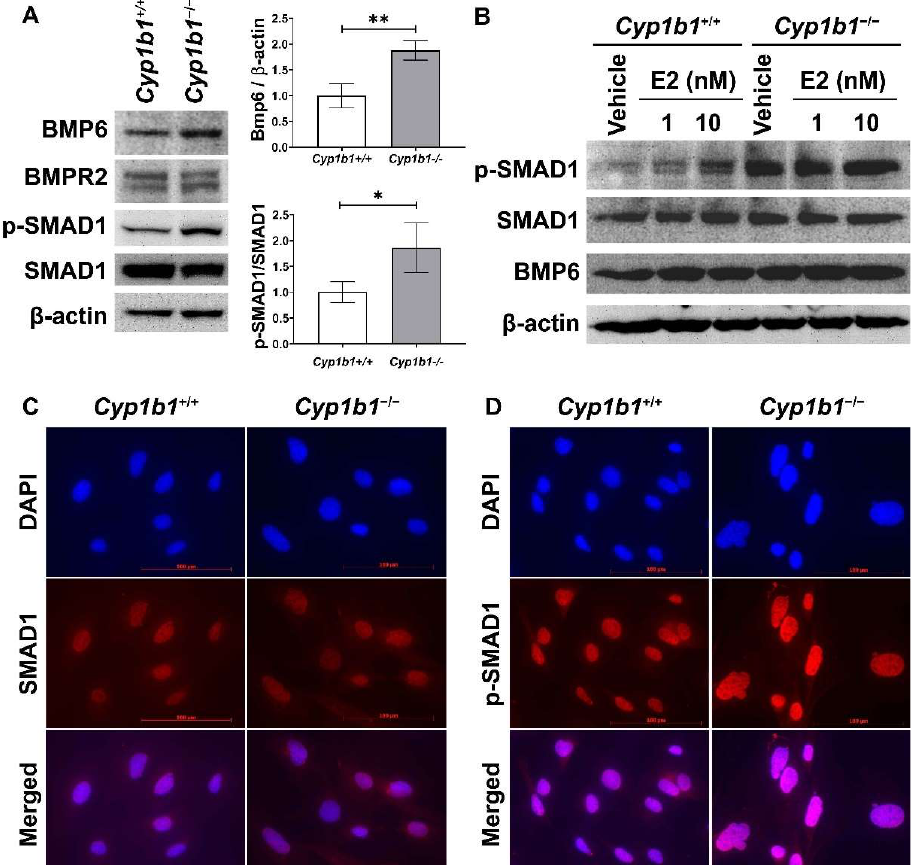
Figure 2. Up-regulation of BMP6 signaling pathway in Cyp1b1 −/− retinal ECs. ( A ) The cell lysates were prepared and used for the analysis of protein levels involved in BMP6 signaling pathway by Western blotting, as detailed in Methods. The levels of BMP6, BMP receptor 2 (BMPR2), p-SMAD1, and SMAD1 proteins were determined using specific antibodies. β-actin levels were determined as a loading control for cell lysates. Band densities were measured from 3 (BMP6/β-actin) and 4 (pSMAD1/SMAD1) blots and analyzed using ImageJ (right panel, * p < 0.05, ** p < 0.01). ( B ) Cyp1b1 +/+ and Cyp1b1 −/− retinal ECs were incubated with 1 nM or 10 nM of 17β-estradiol (E2) for 24 h. The cell lysates were collected for Western blot analysis to determine BMP6, p-SMAD1, and SMAD1 levels. Nuclear localization of SMAD1 ( C ) and p-SMAD1 ( D ) in Cyp1b1 +/+ and Cyp1b1 −/− retinal ECs was determined by indirect immunofluorescence staining. SMAD1 and p-SMAD1 were labeled as red and DAPI (blue) was used to stain the nuclei of the cells (scale bars = 100 µm). We next examined the levels of proteins involved in the BMP6 signaling pathway via Western blot analysis. Both Cyp1b1 +/+ and Cyp1b1 −/− retinal ECs expressed BMP receptor type II (BMPRII), the receptor to which BMP6 binds with high affinity [33]. SMAD1, 5, and 8 are transcription factors and the major intracellular mediators of BMP signaling [34], duce BMP6 expression and/or activate its downstream signaling pathway in Cyp1b1 +/+ ret- inal ECs. Cyp1b1 +/+ and Cyp1b1 −/− retinal ECs were incubated with E2 (1 or 10 nM) for 24 h nucleus [35]. Cyp1b1 − / − retinal ECs exhibited enhanced SMAD1 phosphorylation levels